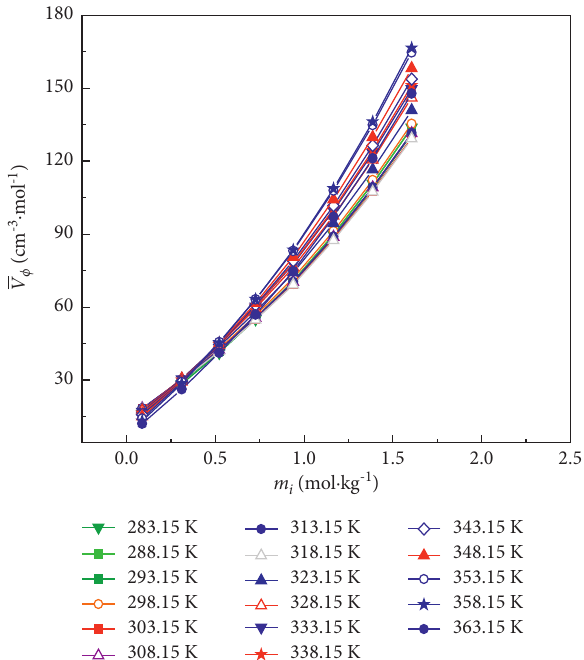
Figure 4: Partial molar volumes of the solute of YCl solutions against temperature and molality.